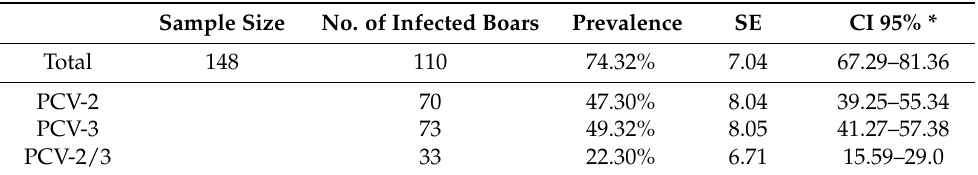
Table 1. Molecular prevalences of PCV-2 and PCV-3 infections and co-infections in the wild boar population ( n = 148 animals) in the Campania region,